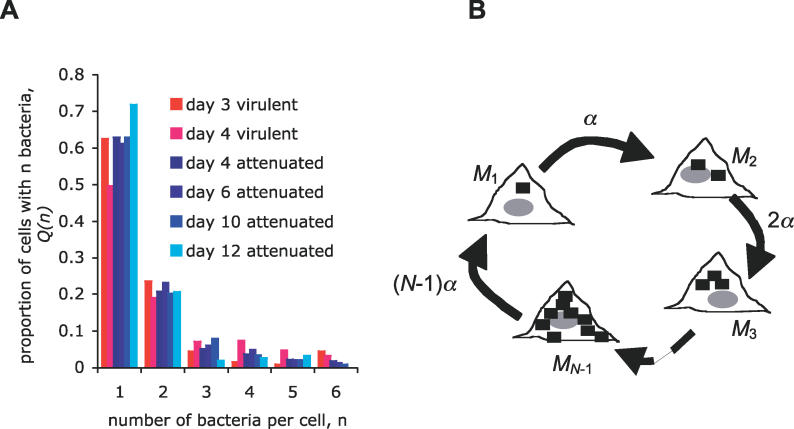
Within-Host Distribution and Growth of Salmonellae(A) Distributions of bacterial charges, Qn, during the course of infection. Data [7] for “virulent” (SL5560, red shades) and “attenuated” (SL3261, blue shades) infections. Bacteria contained within CD18+ phagocytic cells were visualized by immunostaining tissue sections from infected mice. (B) Threshold burst model schema. Triangles represent a host cell through four moments in time. First, the host cell is infected with a single bacterium (rectangle). This bacterium divides at rate α, entailing a transition from single (M
1
) to double (M
2
) infection. The transition from M
2 to M
3 occurs at rate 2α (assume equal and constant division rate for each bacterium, i.e. asynchronous division). Subsequent transitions from Mn to Mn
+1 occur at rate nα, up to final division (at rate (N−1)α) when the host cell bursts to release N bacteria which instantly infect N new host cells.